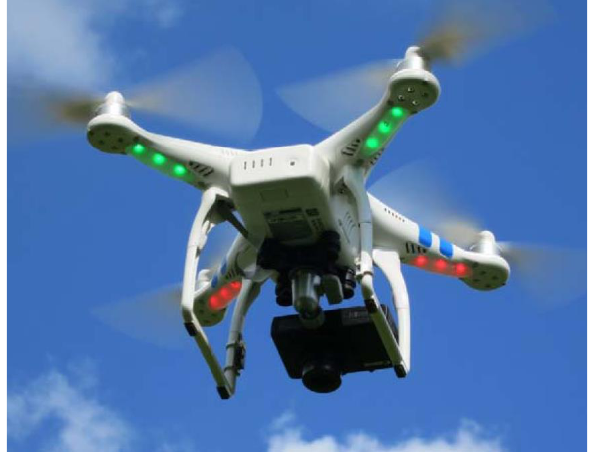
Figure 2. DJI Phantom 2 with mounted Canon Powershot 110 (Bareth et al. 2015)